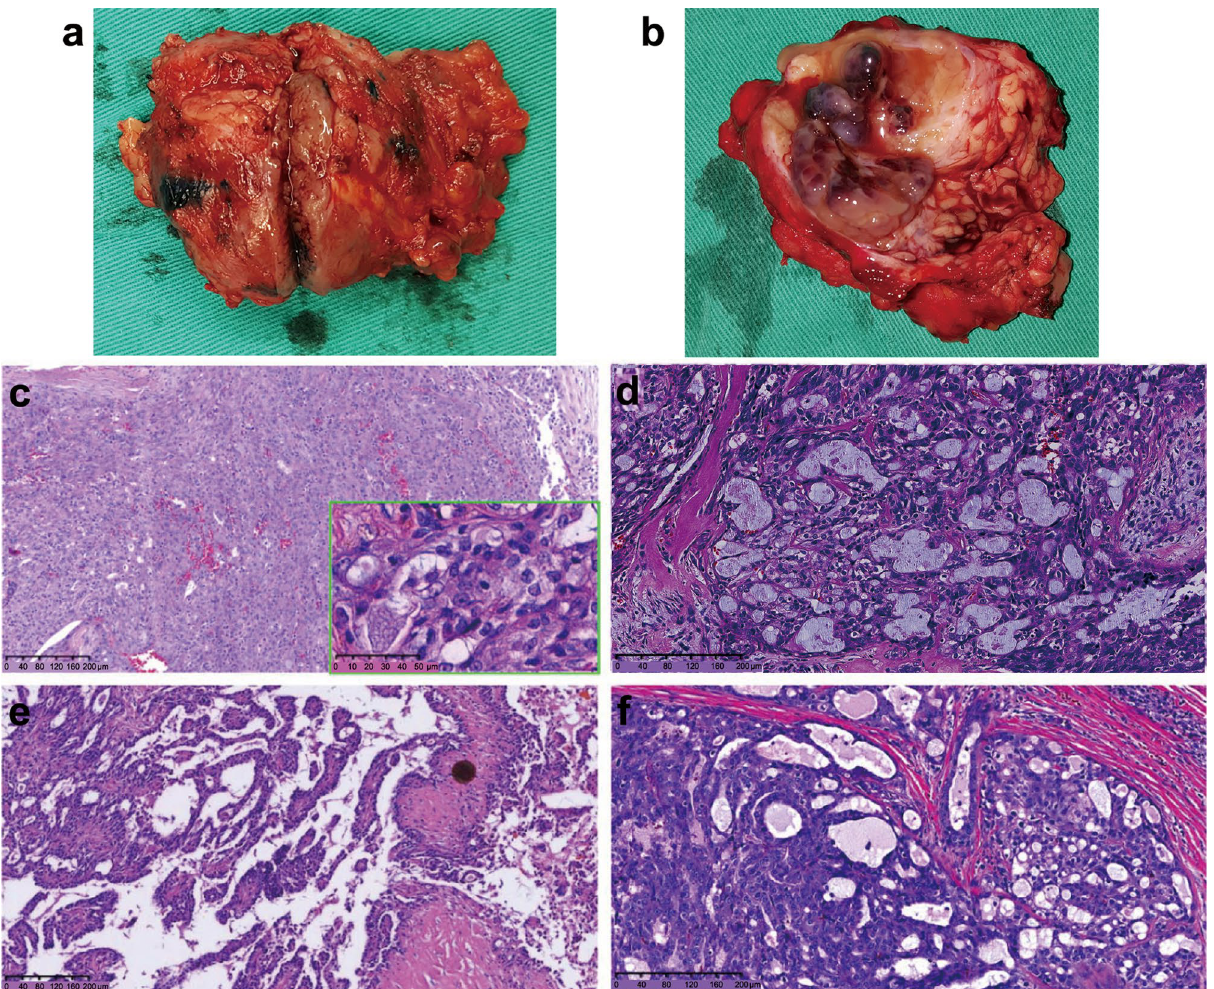
Figure 4. Pathological characteristics. ( a ) An isolated solid nodule tumor with light-tan or grayish cut surface. ( b ) Tumor-harboring cysts containing yellowish-white fluid; ( c ) solid structures; ( d ) microcystic structures; ( e ) follicular and papillary cystic structures; ( f ) tubular structures. At high magnification, the tumor cells are round or oval with little atypia. They have eosinophilic granular or vacuolated cytoplasm with small, uniform nuclei (green